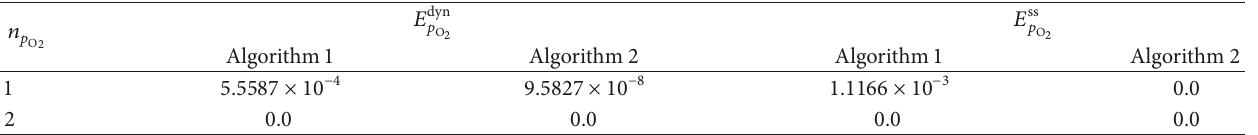
and the steady-state error 𝐸 ss 𝑝 O 2